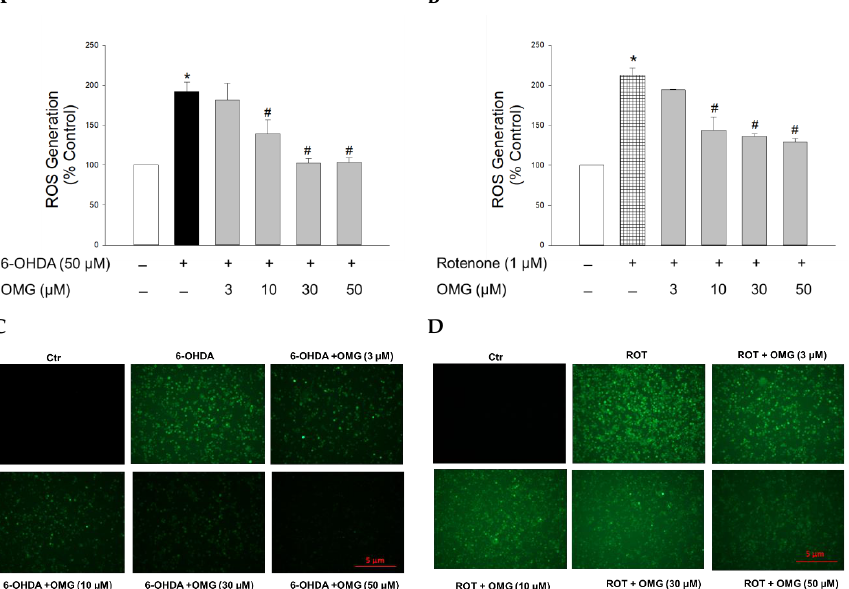
Figure 3. Effects of OMG on the 6-OHDA- or rotenone-induced ROS generation in PC12 cells. PC12 cells were pretreated with OMG at the indicated concentrations for 4 h and subsequently exposed to ( A ) 6-OHDA or ( B ) rotenone for 6 h. Then, cells were loaded with 25 μM DCFH-DA at 37 °C for 1 h in the dark, and the intracellular ROS levels were assessed by the fluorescence emission of 2′,7′-dichlorofluorescein, as described in the Materials and Methods section. Intracellular levels of ROS are presented as the percentage of the vehicle-treated control cells. Each data point is displayed as the mean ± SEM from three independent experiments conducted in triplicate. *, p < 0.05 and # , p < 0.05 vs. vehicle-treated control cells and 6-OHDA- or rotenone-treated cells, respectively. Immunofluorescence images of the cells treated with OMG and ( C ) 6-OHDA or ( D ) rotenone were obtained as described in the Materials and Methods. Representative images are shown (scale bar, 5 μm). OMG, omarigliptin; 6-OHDA, 6-hydroxydopamine; ROT, rotenone; ROS, reactive oxygen species; Ctr, control.